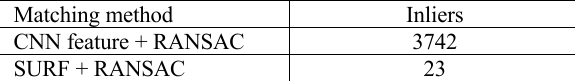
Table 2. Comparison on feature matching performance between CNN and SURF features in texture-less area.